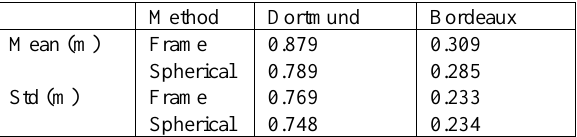
Table 2 . Mean absolute distance and standard deviation of the cloud-to-cloud evaluation for Dortmund and Bordeaux